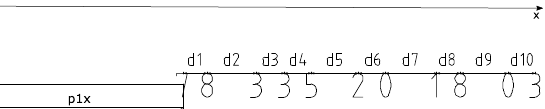
Figure 1. Image used for calculating template values, such as the distances between digits.